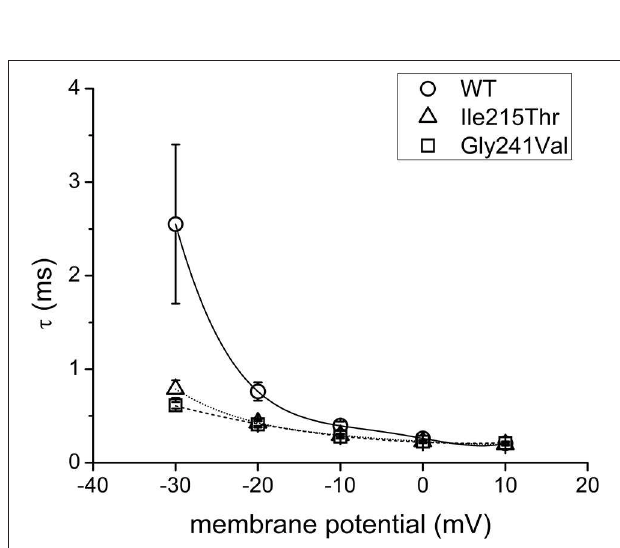
FIGURE 4 | Curves illustrating the time constants ( τ ) for WT and mutant channel current decay in the range of potentials from − 30 to